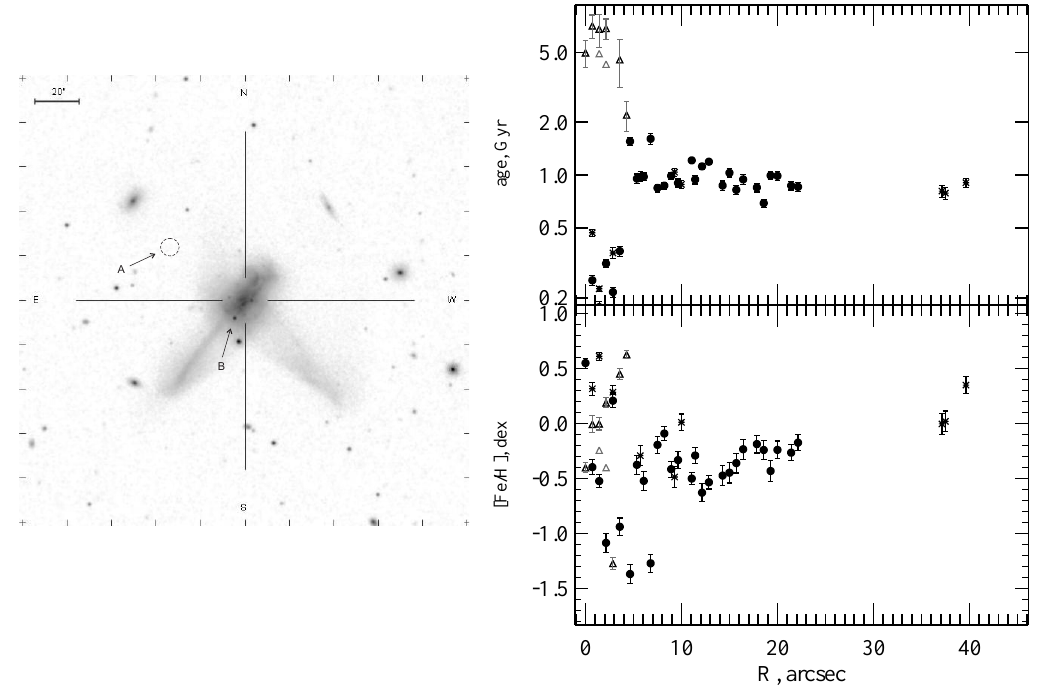
Figure 1. Left : the gri image of IC 883 from the Sloan Digital Sky Survey (http://www.sdss.org/). Arrows indicate the “A” and “B” regions discussed in the paper. North is up and east is to the left. 1 (cid:48)(cid:48) corresponds to 0.5 kpc, H 0 = 72 km/s/Mpc, the distance to the galaxy is 97.4 Mpc. Right : Dependences of age ( top ) and metallicity ( bottom ) of the stellar population on distance along the major axis of IC 883: (cid:52) —old stellar population; ∗ —young stellar population in the SE-side; • —young stellar population in the